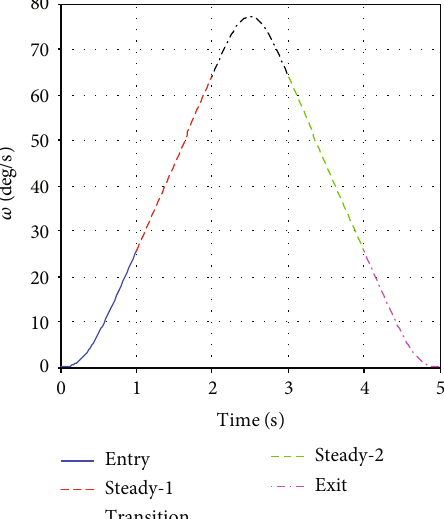
Figure 5: Trajectory of angular rate of attitude.